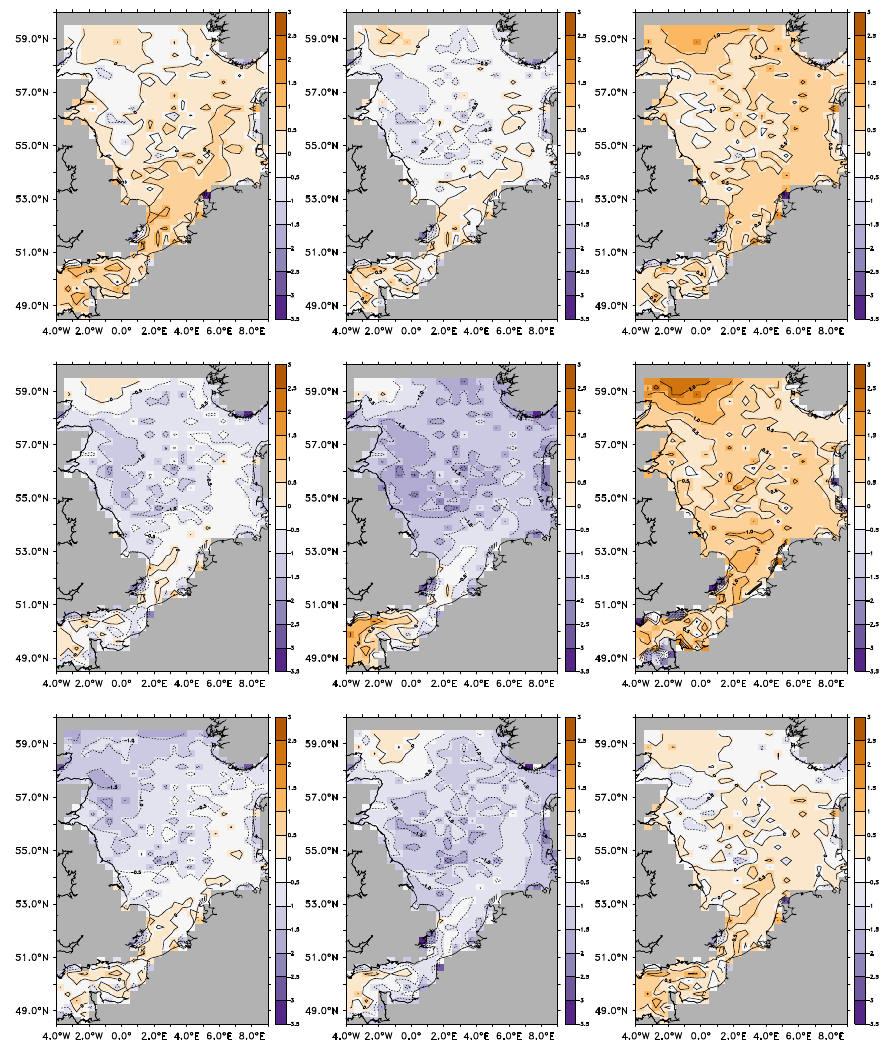
Figure 2. Climatological annual mean SST biases ( ◦ C) for differentRCA4-NEMO experiments relative to KNSC. ERA40 ( upper row, left ), Ensemble mean ( upper row, middle ), MPI-ESM-LR ( upper row, right ), EC-EARTH ( middle row, left ), GFDL-ESM2M ( middle row, middle ), HadGEM2-ES ( middle row, right ), IPSL-CM5A-MR ( lower row, left ), ECHAM5 ( lower row, middle ), and ocean only run ( lower row, right